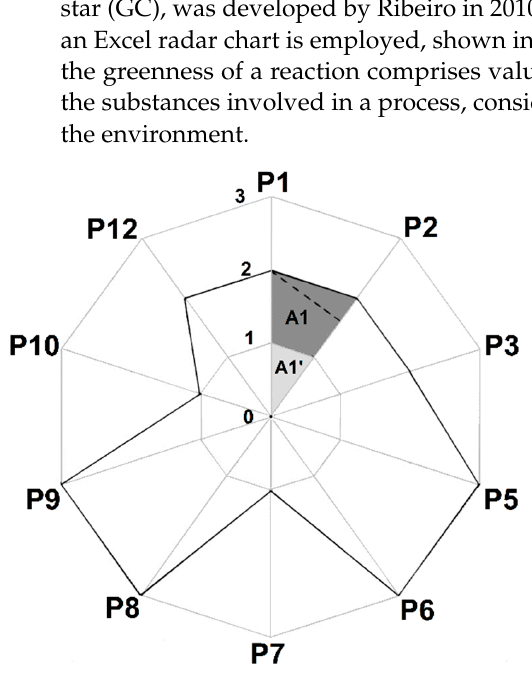
Figure 6. GS model using the 12 principles (P1-12). A1 and A1’ meaning the area of triangle. Adapted from Ref. [70].